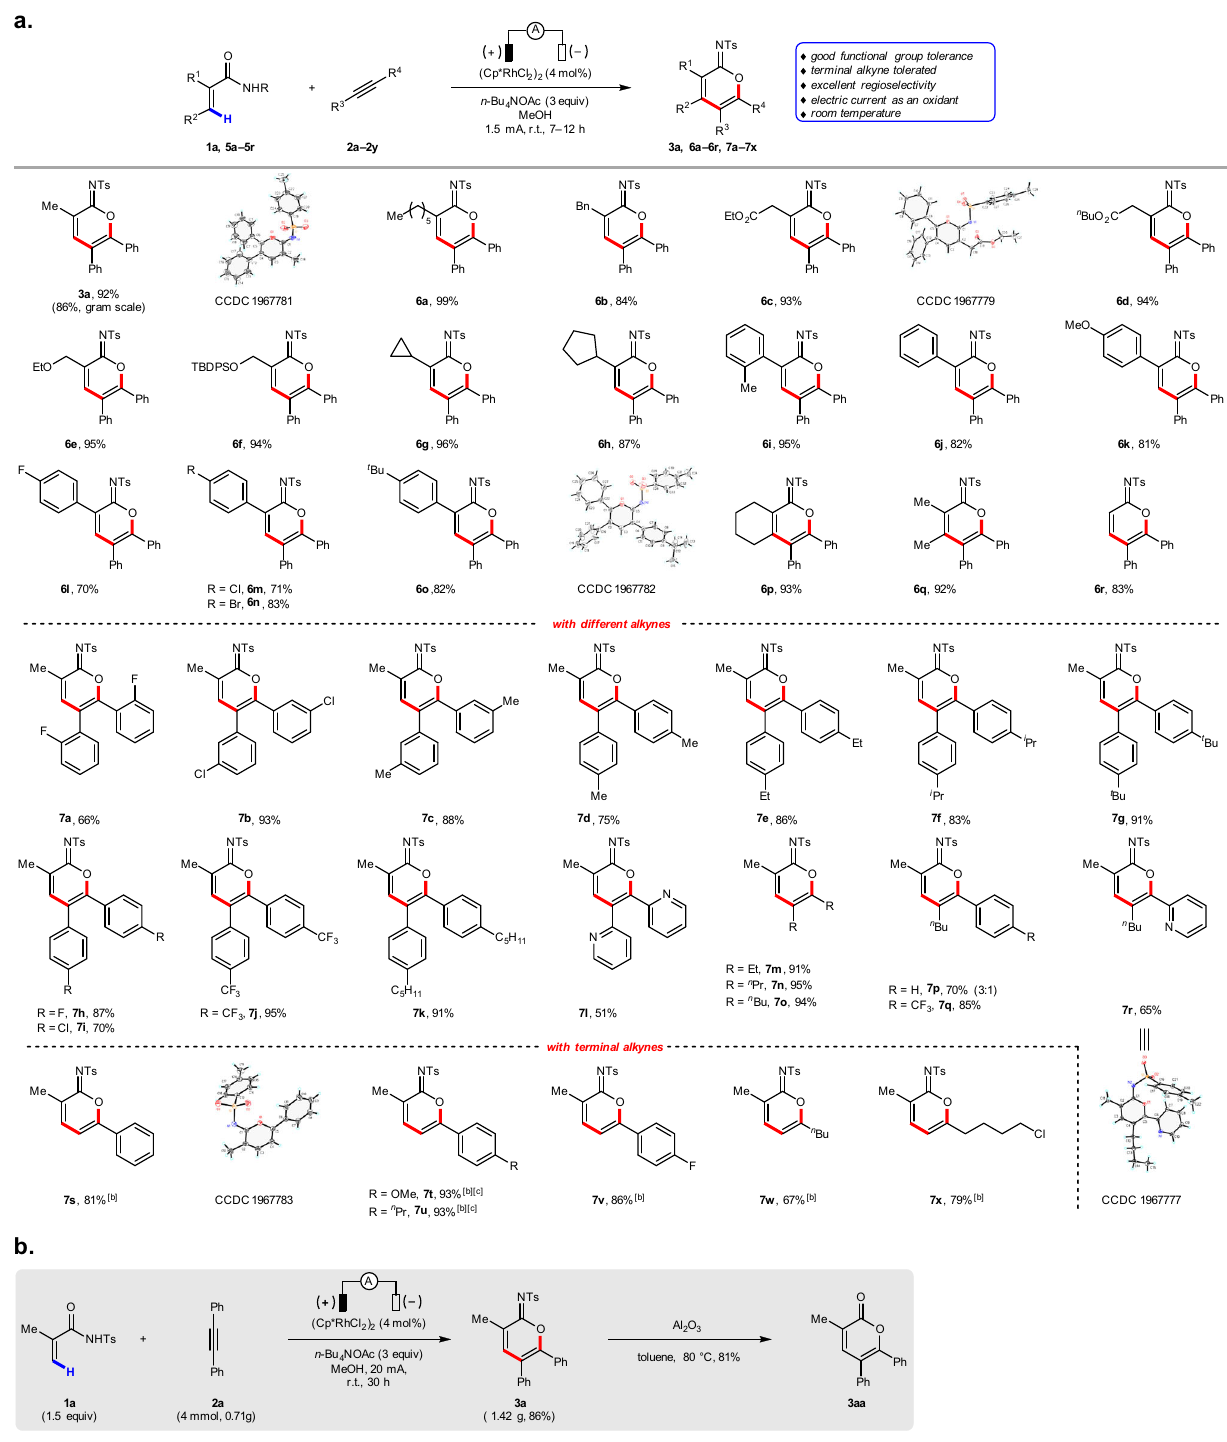
Fig. 2 Scope of cyclic imidates and synthetic application. a Substrate scope synthesis of cyclic imidates with IKA Electrasyn 2.0. a Isolated yields are reported. Reaction conditions: 1a or 5 (0.3 mmol), 2 (0.2 mmol), (Cp*RhCl 2 ) 2 (4 mol%), n -Bu 4 NOAc (3.0 equiv.), and MeOH (6 mL) in an undivided cell with two platinum electrodes (each 3.0 × 0.8 cm 2 ), room temperature, 1.5 mA, 7 – 12 h. b 5 (0.15 mmol), 2 (0.3 mmol). c The reaction was carried out at 60 °C. b Gram-scale experiment and synthetic